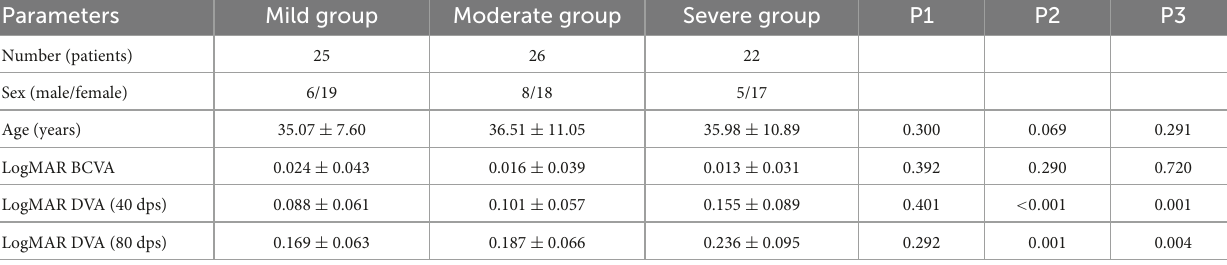
TABLE 3 Comparison of DVA among different Meibomian gland (MG) grades in the upper eyelid. Parameters